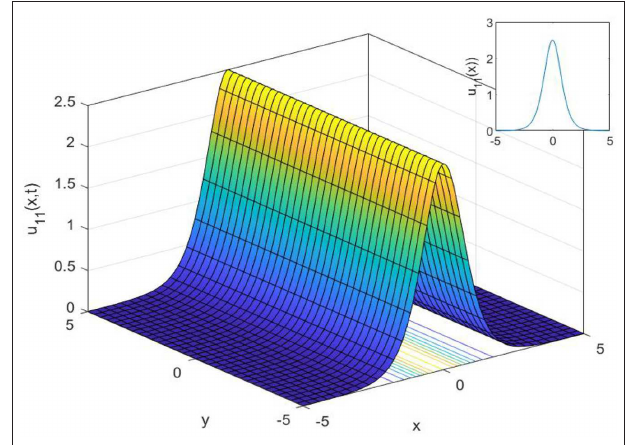
FIGURE 11 | The 3D, 2D, and contour surfaces of Equation (43) using A 1 5, α 4, and ǫ = = =